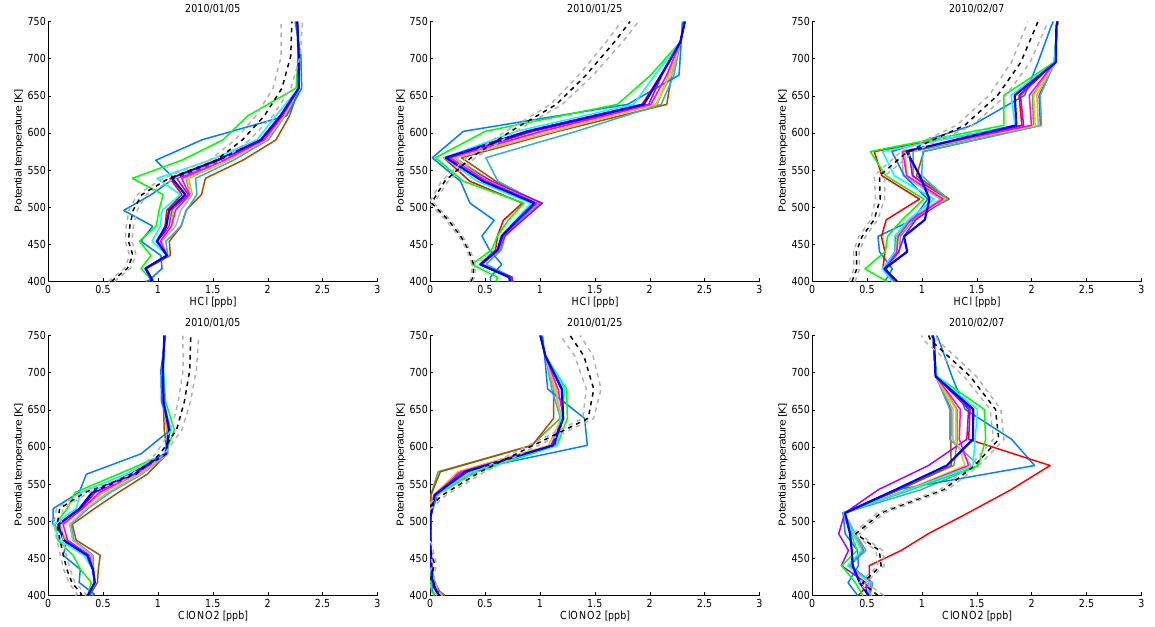
Fig. 7. HCl and ClONO 2 as a function of potential temperature for all sensitivity runs and the reference run for three selected locations in the vortex on different days (5 January at 56.8 ◦ N and 15.1 ◦ E, 25 January at 65.2 ◦ N and 69.4 ◦ E, 7 February at 67.4 ◦ N and 29.3 ◦ E). Colours indicate the different sensitivity runs (see legend in Fig. 5). The black dashed lines show corresponding measurements from ACE-FTS. The grey dashed lines show the statistical error of the